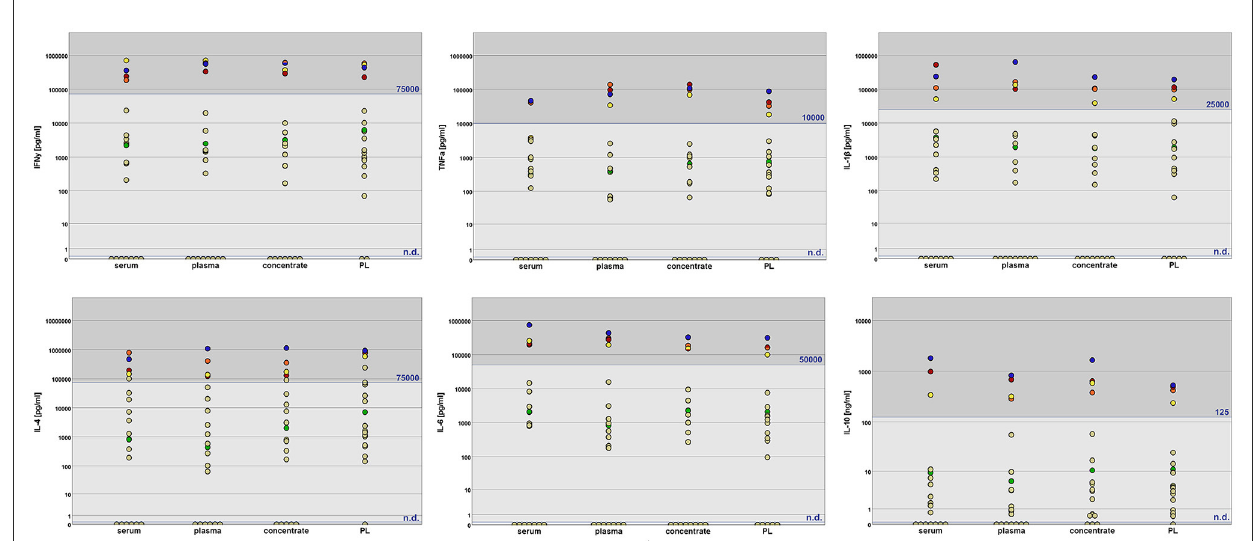
FIGURE2 Cytokine concentrations in equine serum, plasma, platelet concentrate and platelet lysate (PL) as measured by sandwich ELISA. The assigned concentration categories are indicated by dark gray (category 3), gray (category 2) and light gray (category 1) background. The thresholds between category 2 and 3 are given in blue letters; category 1 corresponds to no detectable cytokine content (n.d.). Data from donors with abnormal findings in blood chemistry are highlighted in different colors (horse 1: orange; horse 2: red; horse 12: green; horse 18: yellow; horse 19: blue). The cytokine concentration categories were significantly higher in these animals as compared to the others ( p < 0.01, except for IL-4 in